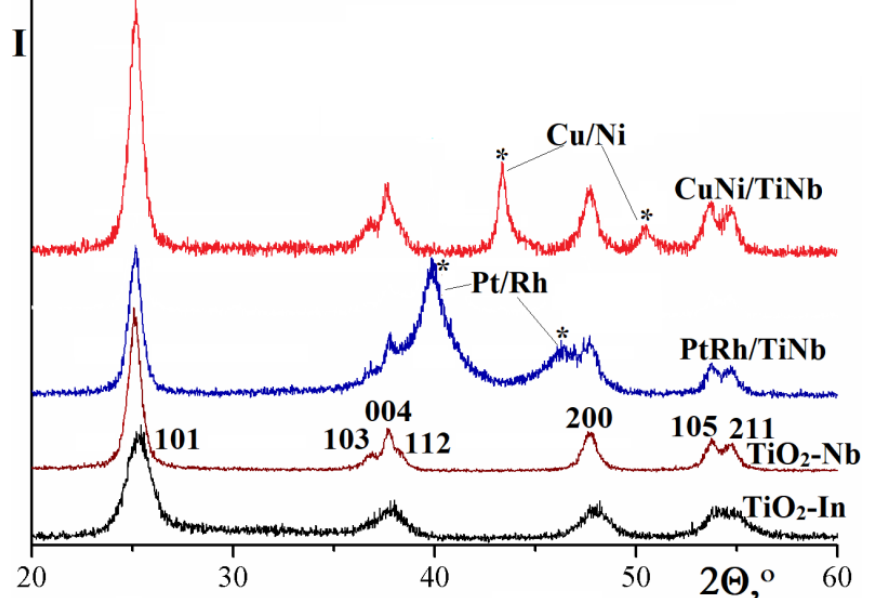
Figure 2. X-ray diffraction patterns of titanium oxide samples doped with indium, niobium and the catalysts based on them. The reflections corresponding to the bimetallic alloys are marked with asterisks (*).